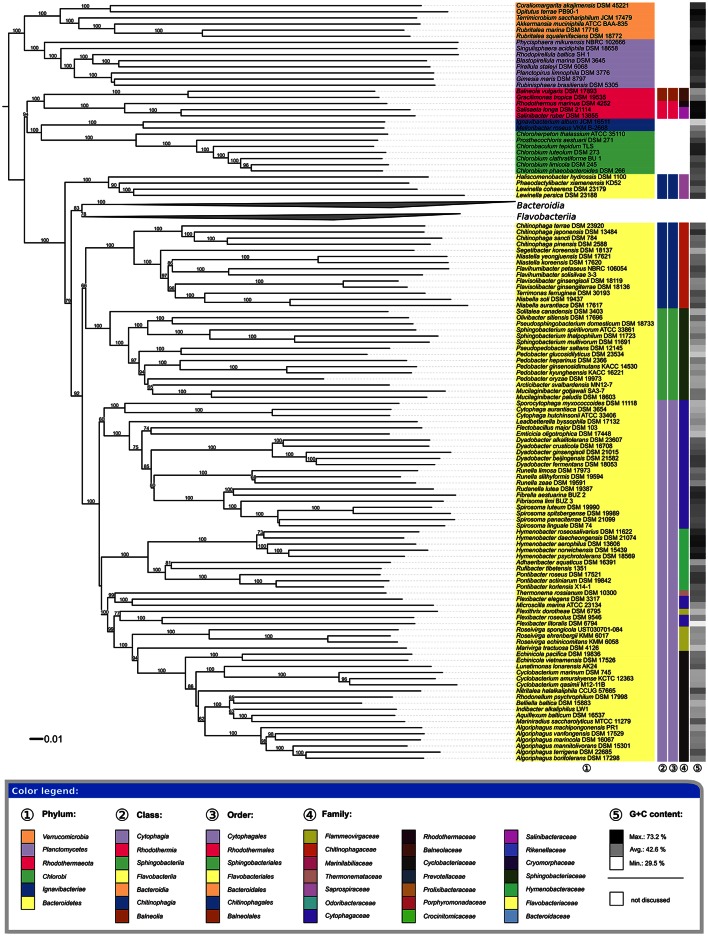
First part of the phylogenomic tree inferred with GBDP. Tree inferred with FastME from GBDP distances calculated from whole proteomes. The numbers above branches are GBDP pseudo-bootstrap support values from 100 replications. Tip colors indicate the phylum, colors to the right of the ingroup tips indicate, from left to right, class, order and family (see the embedded legend for details). Gray scale on the very right indicates the exact G+C content as calculated from the genome sequences. The Bacteroidia and Flavobacteriia parts of the tree, which have been collapsed here, are shown in Figures 3, 4.